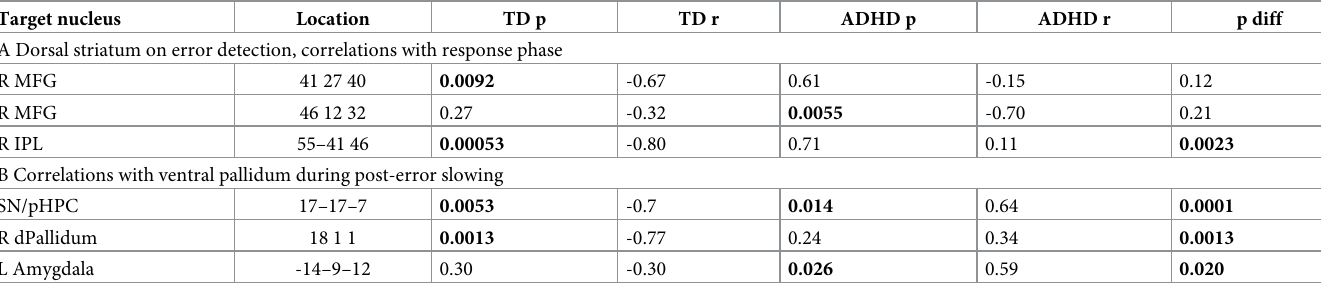
P-values in bold type passed cluster thresholding correction. DS = dorsal striatum, MFG = middle frontal gyrus, IPL = inferior parietal lobule, pHPC = parahippocampus, dPallidum = dorsal pallidum, R = right; L = left; Location (Talairach space), p-values and correlation coefficients (r) for TD and ADHD, and p-values for group difference (TD-ADHD = diff). See also S2